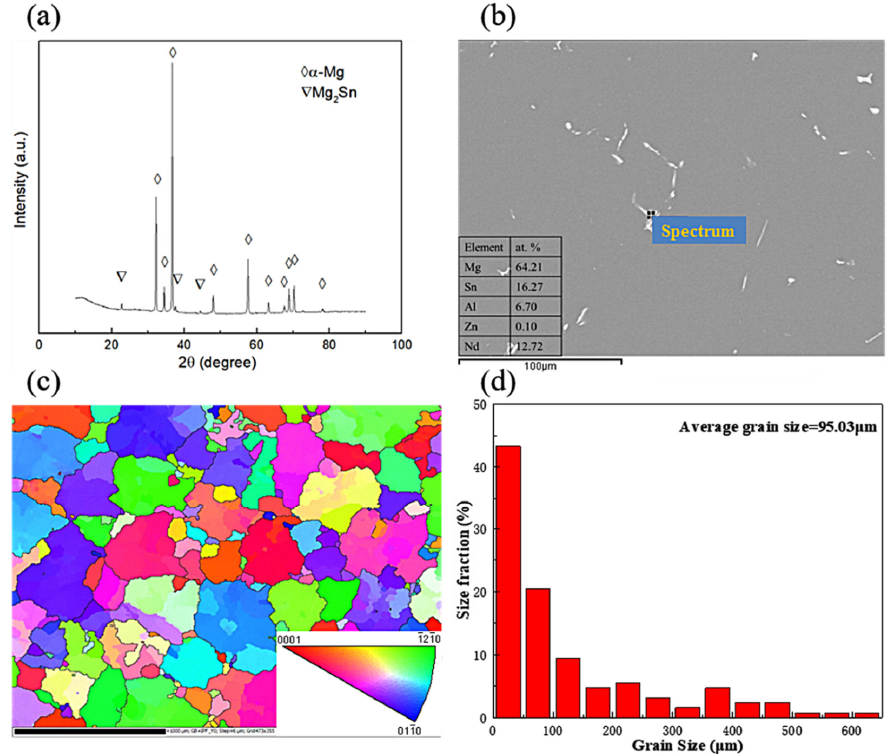
Figure 1. Microstructure of the as-homogenized Mg-3Sn-2Al-1Zn-0.6Nd alloy ( a ) XRD imagine; ( b ) EDS map; ( c ) IPF map; ( d ) grain distribution statistics map. ( b ) EDS map; ( c ) IPF map; ( d ) grain distribution statistics